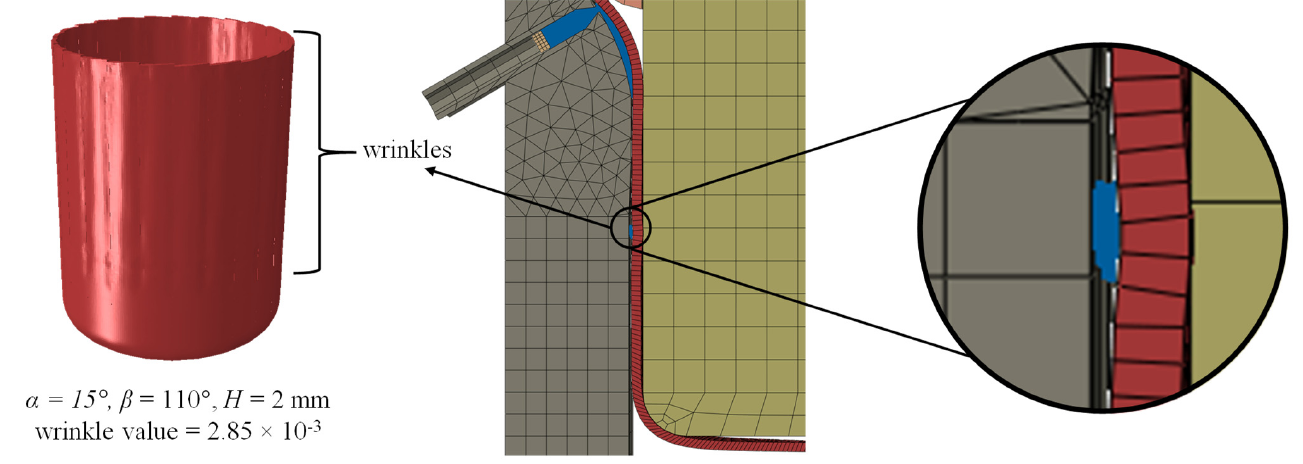
Figure 15. Wrinkling due to entrained SPH particles.